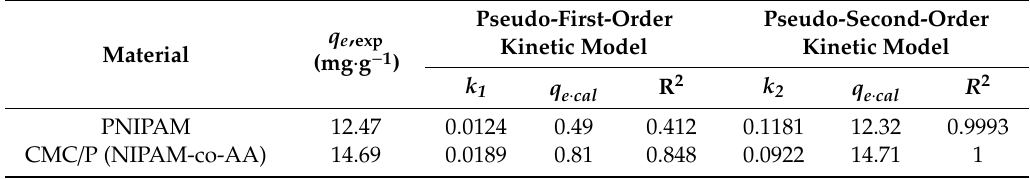
Table 6. Kinetic parameters of adsorption of PNIPAM and CMC / P (NIPAM-co-AA) at 298 K.